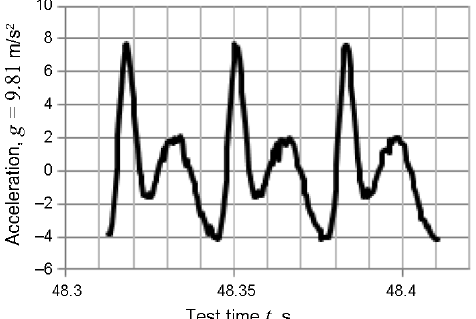
Fig. 4. Typical records for the pile subjected to 30 Hz vibratory loadings and 120 kg static load surcharge after settlement pro- cess was stopped